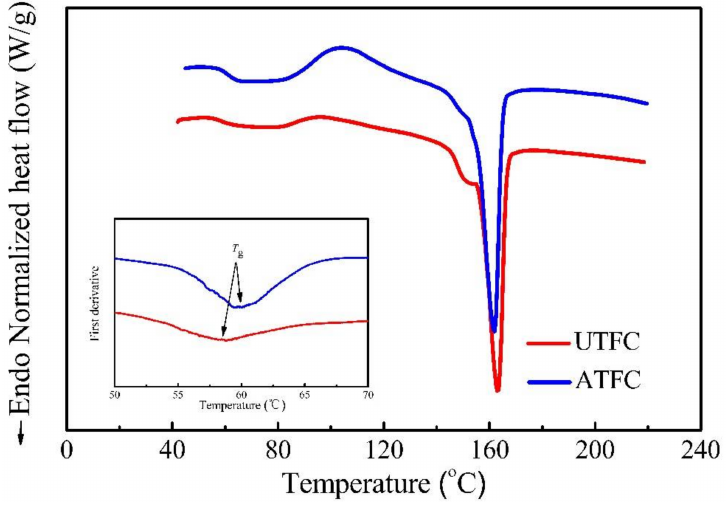
Figure 7. DSC curves of PLA-based composites reinforced with untreated and treated BFs.